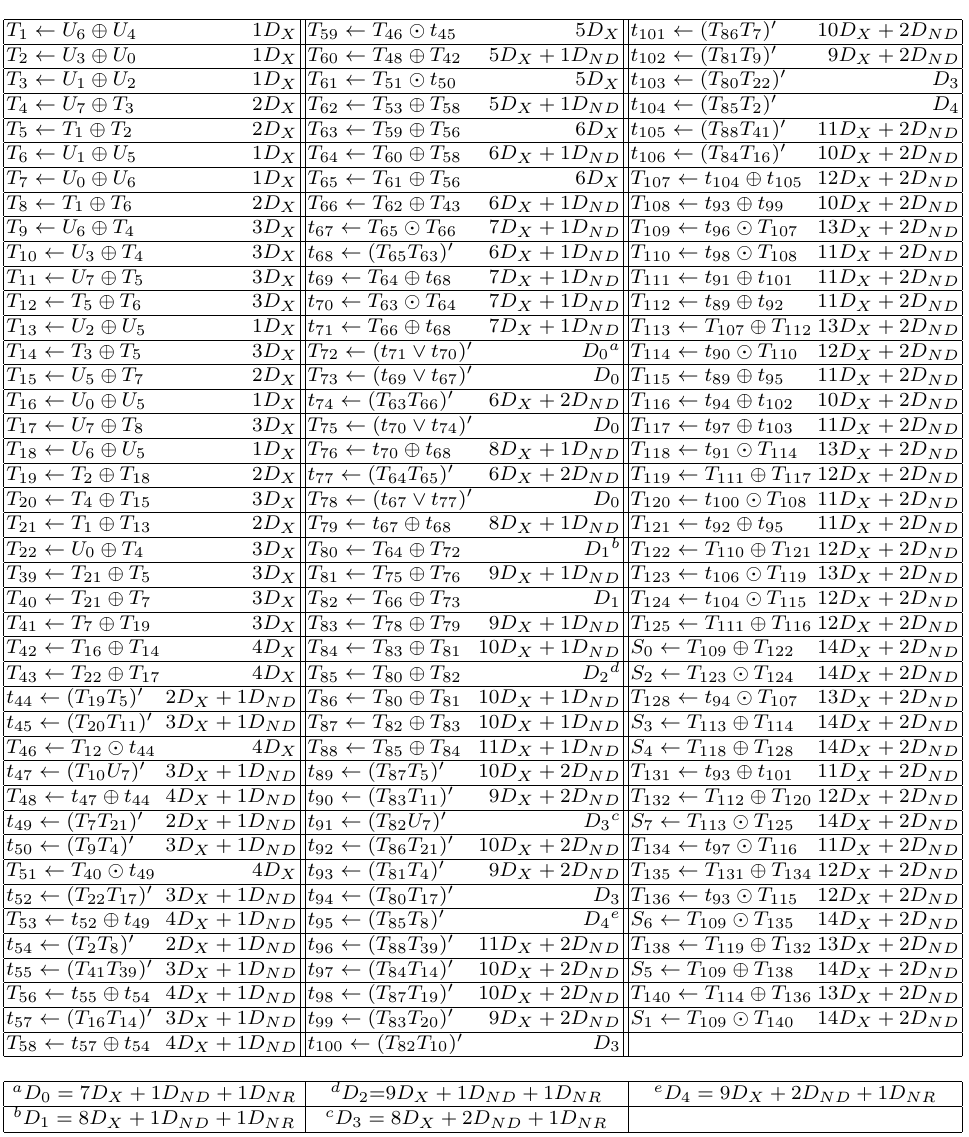
Table 16: Formulations of the improved Boyar-Dp16-2 S-box. The original S-box is found from [BFP17] with formulations from [Boy16]. In this table, we use lower case letters, e.g., t 44 , to represent the complemented signals as compared to the original signals which are represented with capital letters, e.g., T 44 = ( t 44 ) 0